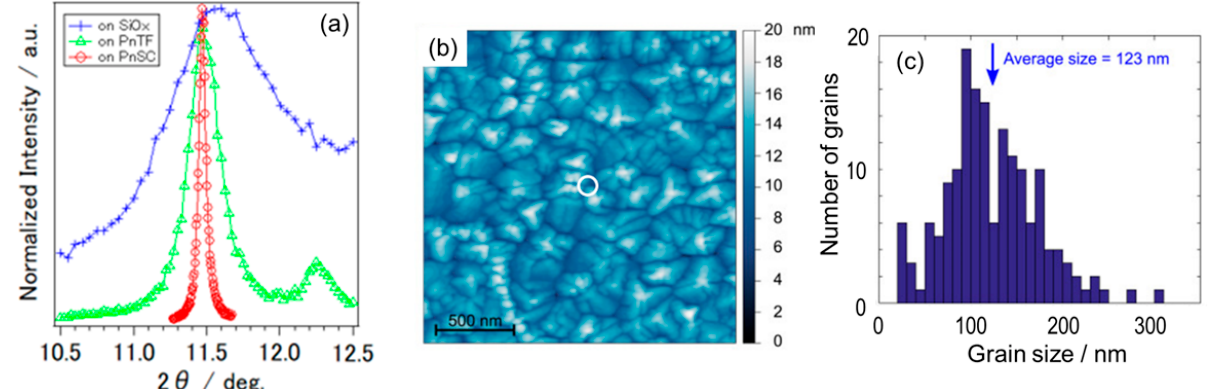
Figure 6. ( a ) 2 θ profiles of the C 60 diffraction spots formed on the single-crystal (red), polycrystalline thin film (green), and Si wafer (blue) substrates. ( b ) AFM image (2 µm × 2 µm) of a C 60 /PnSC sample. ( c ) Distribution of the grain size observed on the AFM image. The diameter of the circle at the center of the image illustrates the mean crystallite size estimated by HR-GIXD. ( b , c ) Cited from [65].